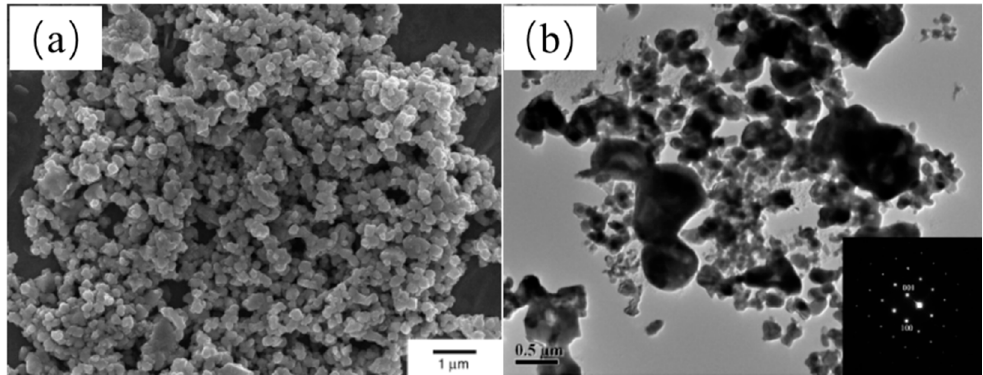
Figure 7. FESEM ( a ) and TEM ( b ) images of the synthesized ZrB 2 powders [70].